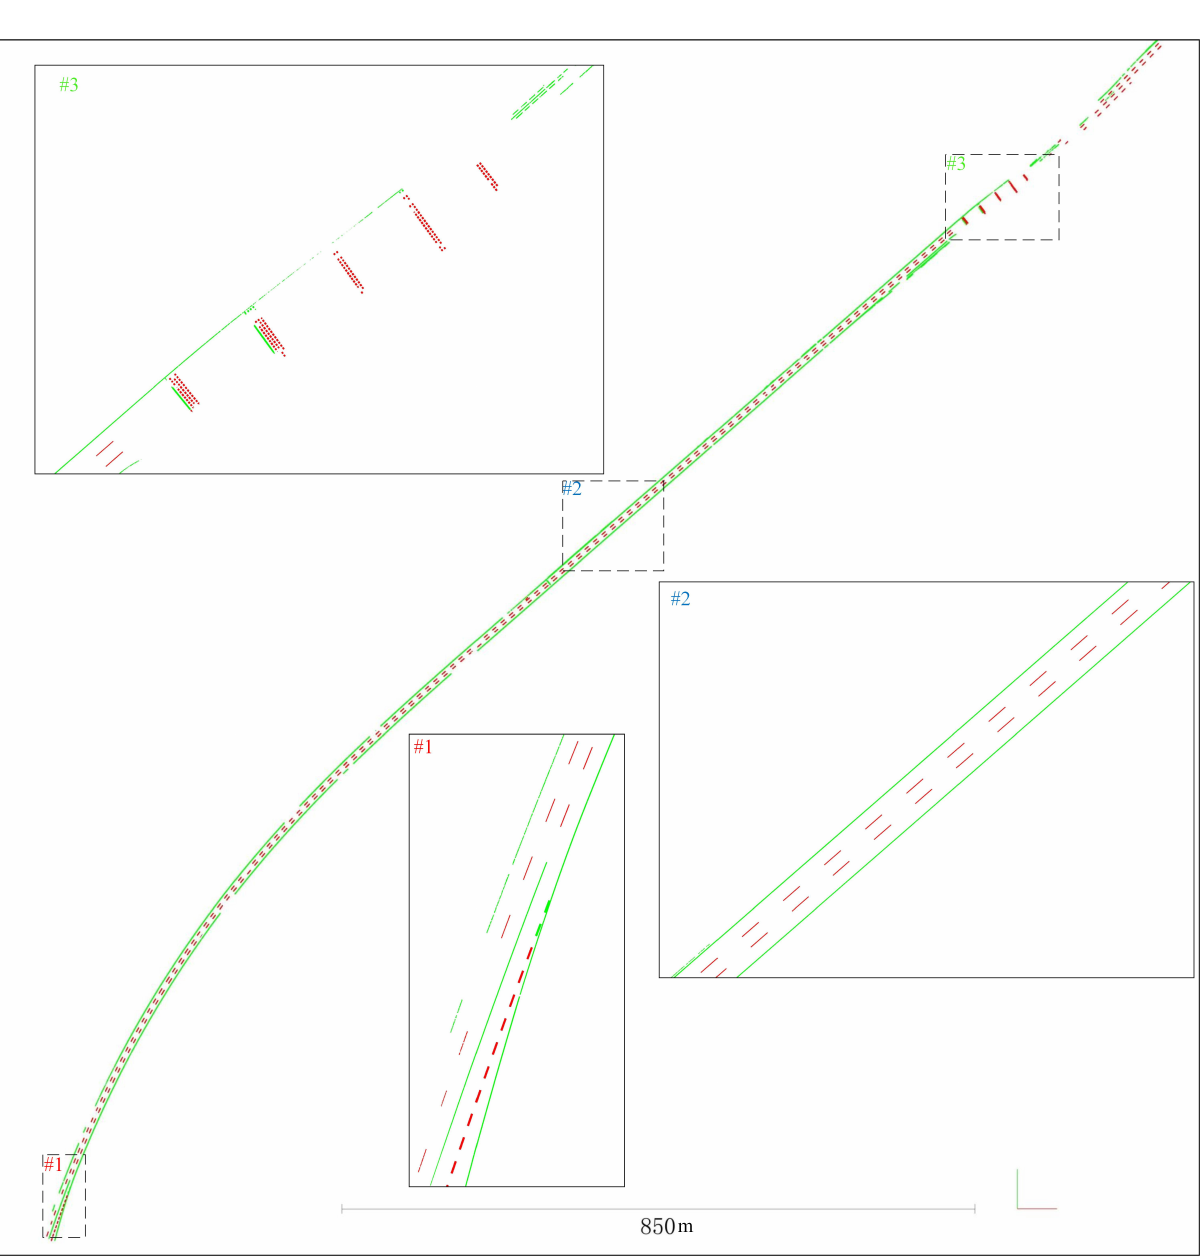
Figure 6. Road markings point clouds detection and classification result for Highway 1 dataset